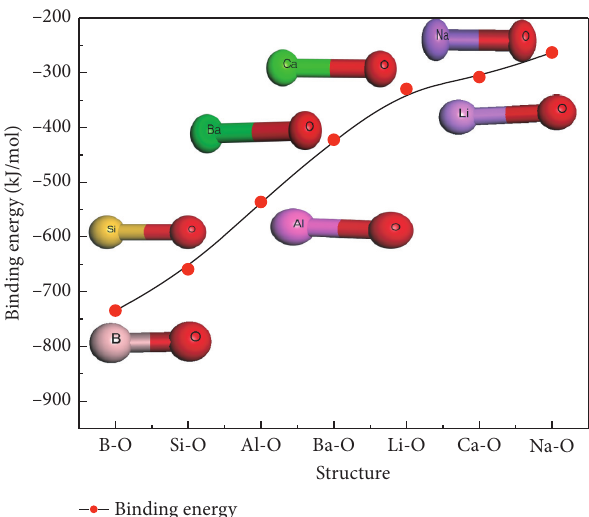
Figure 3: Structural diagram showing the total energy of [AlO and [AlO 6